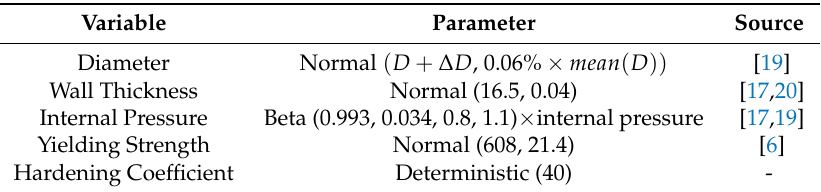
Table 5. The standard